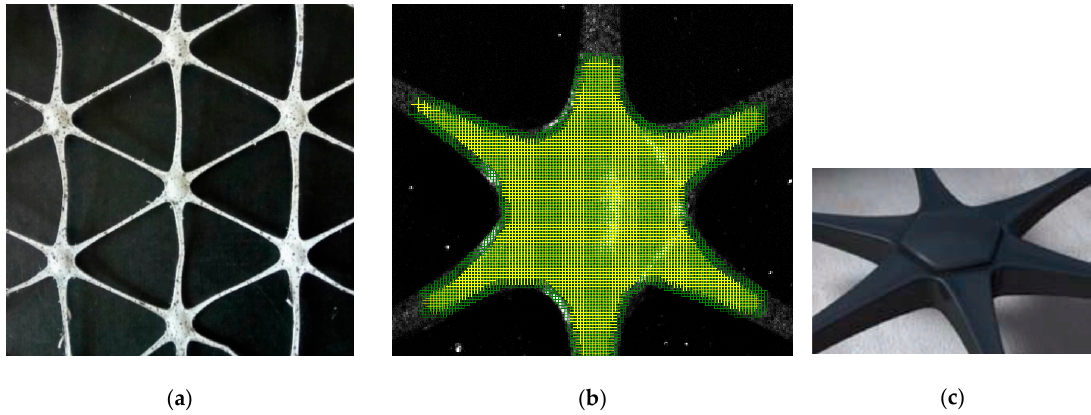
Figure 20. Triaxial hexagonal polypropylene geogrid: ( a ) Geogrid sample prepared for testing (after painting with white paint and spotting with black colour); ( b ) virtual grid of a hexagonal geogrid node; ( c ) geogrid node before painting [38].